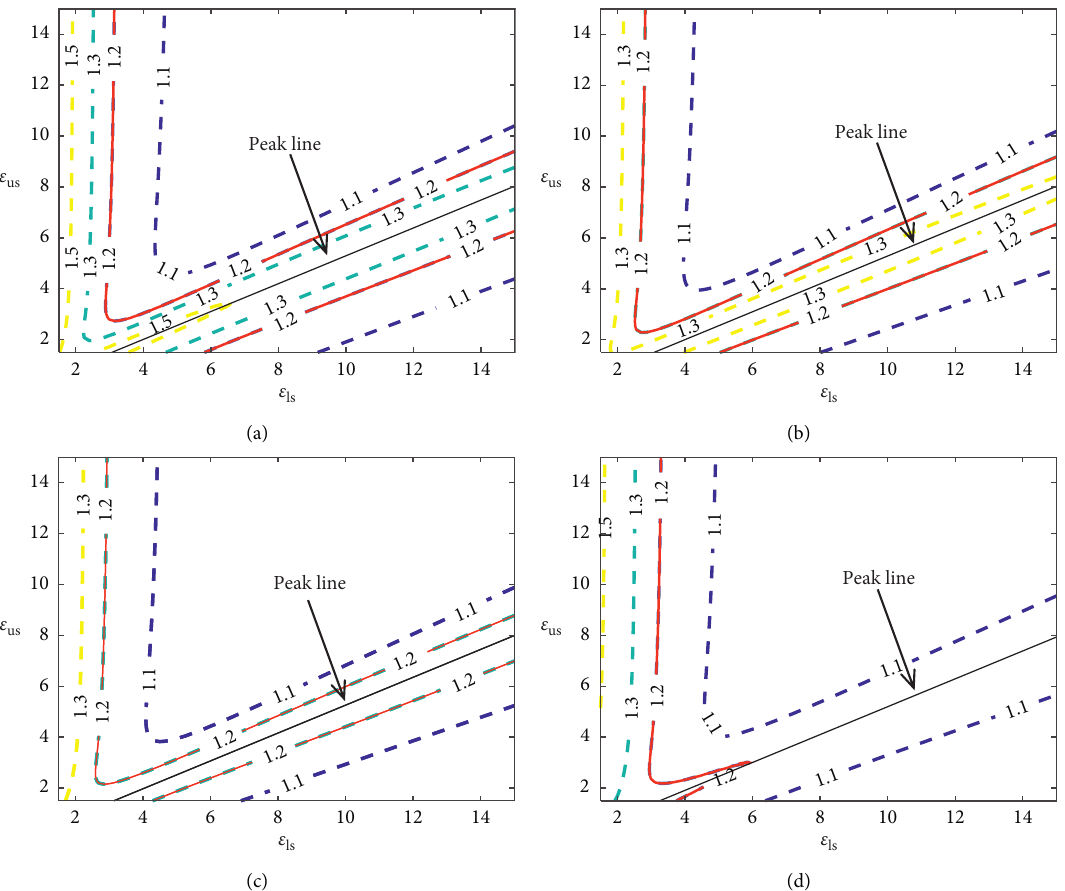
Figure 5: Contour plots of R a r 1 � 0.8 and r 2 � 0.7.